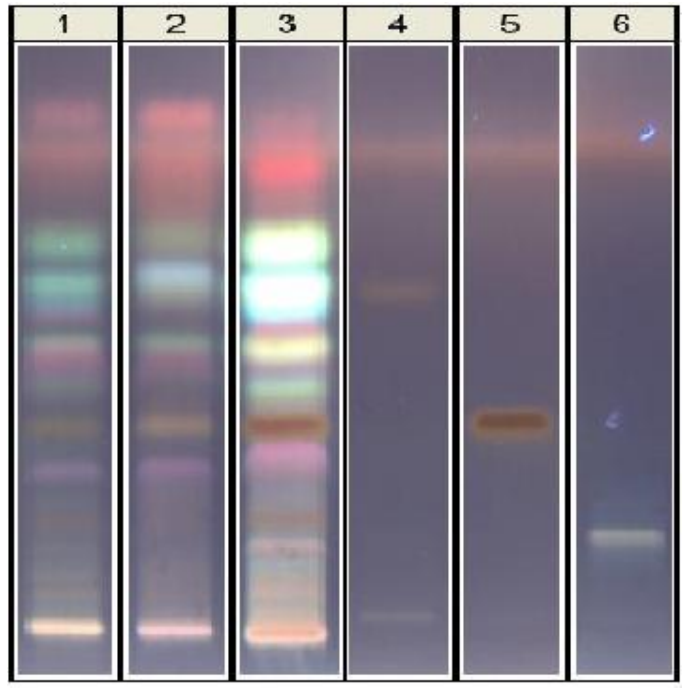
Figure 2. HPTLC analysis of neem cake extracts and selected standards of nortriterpenes. Tracks: 1 , methanol extract after 24 h; 2 , methanol extract after 72 h; 3 , ethylacetate extract; 4 , nimbin; 5 , salannin; 6 , azadirachtin